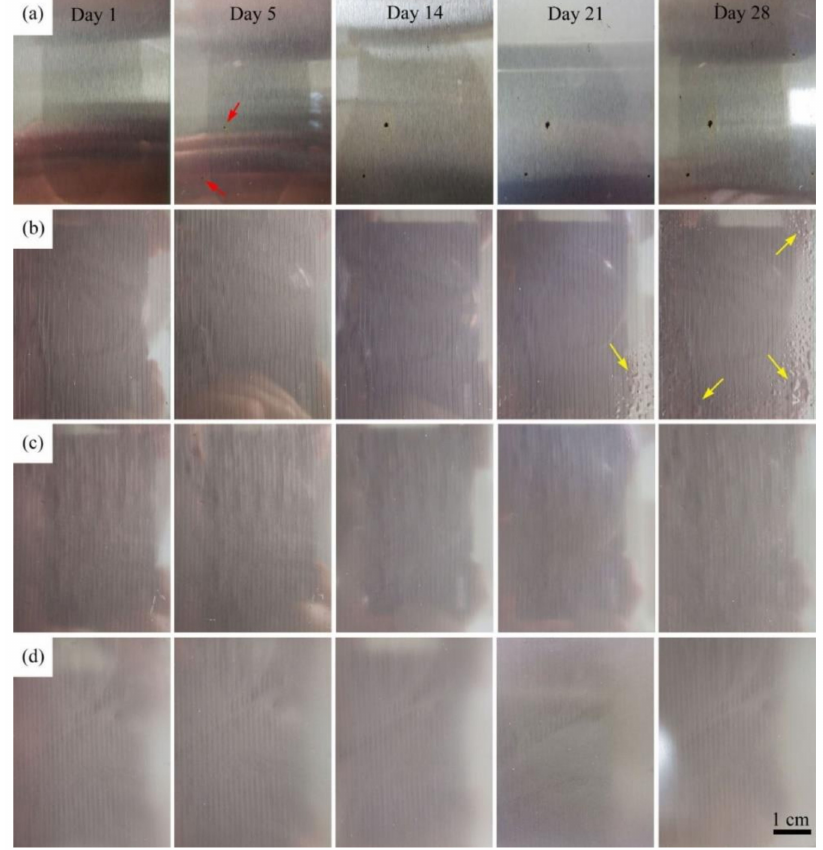
Figure 7. Visual appearance of coating samples after different exposure times in salt spray chamber: ( a ) PU, ( b ) PU2, ( c ) PU4 and ( d )